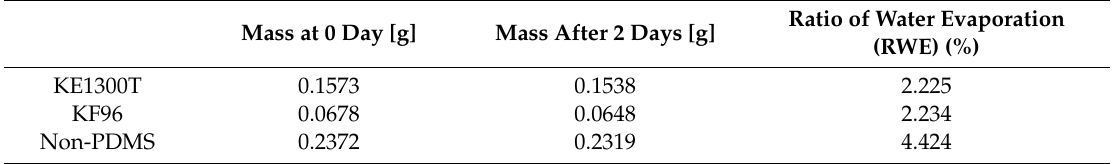
Table 1. Change of the mass of MCF rubber sheet and ratio of water evaporation. Mass at 0 Day Mass After 2 Days Ratio of Water Evaporation (RWE) [g] [g] (%) KE1300T